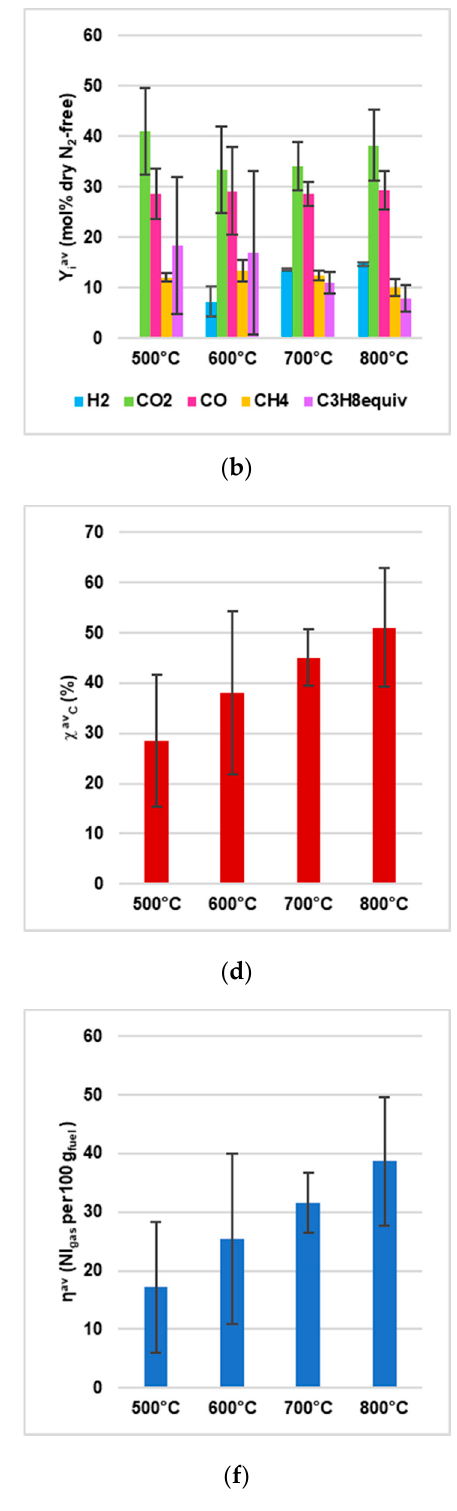
Figure 7. Experimental results of devolatilization tests under nitrogen plus air atmosphere, in the sand fluidized bed, as functions of temperature: integral-average mol% dry, dilution-free ( Y iav , Equation (2)) of AHPam ( a ) AHPus ( b ); integral-average carbon conversion ( χ av C , Equation (3)) of AHPam ( c ) AHPus ( d ); integral-average gas yield ( η av , Equation (1)) of AHPam ( e ) AHPus ( f ); colored bars represent average values out of the three repetitions for each set “material kind/fluidizing agent/bed temperature”, errors bars quantify the related standard